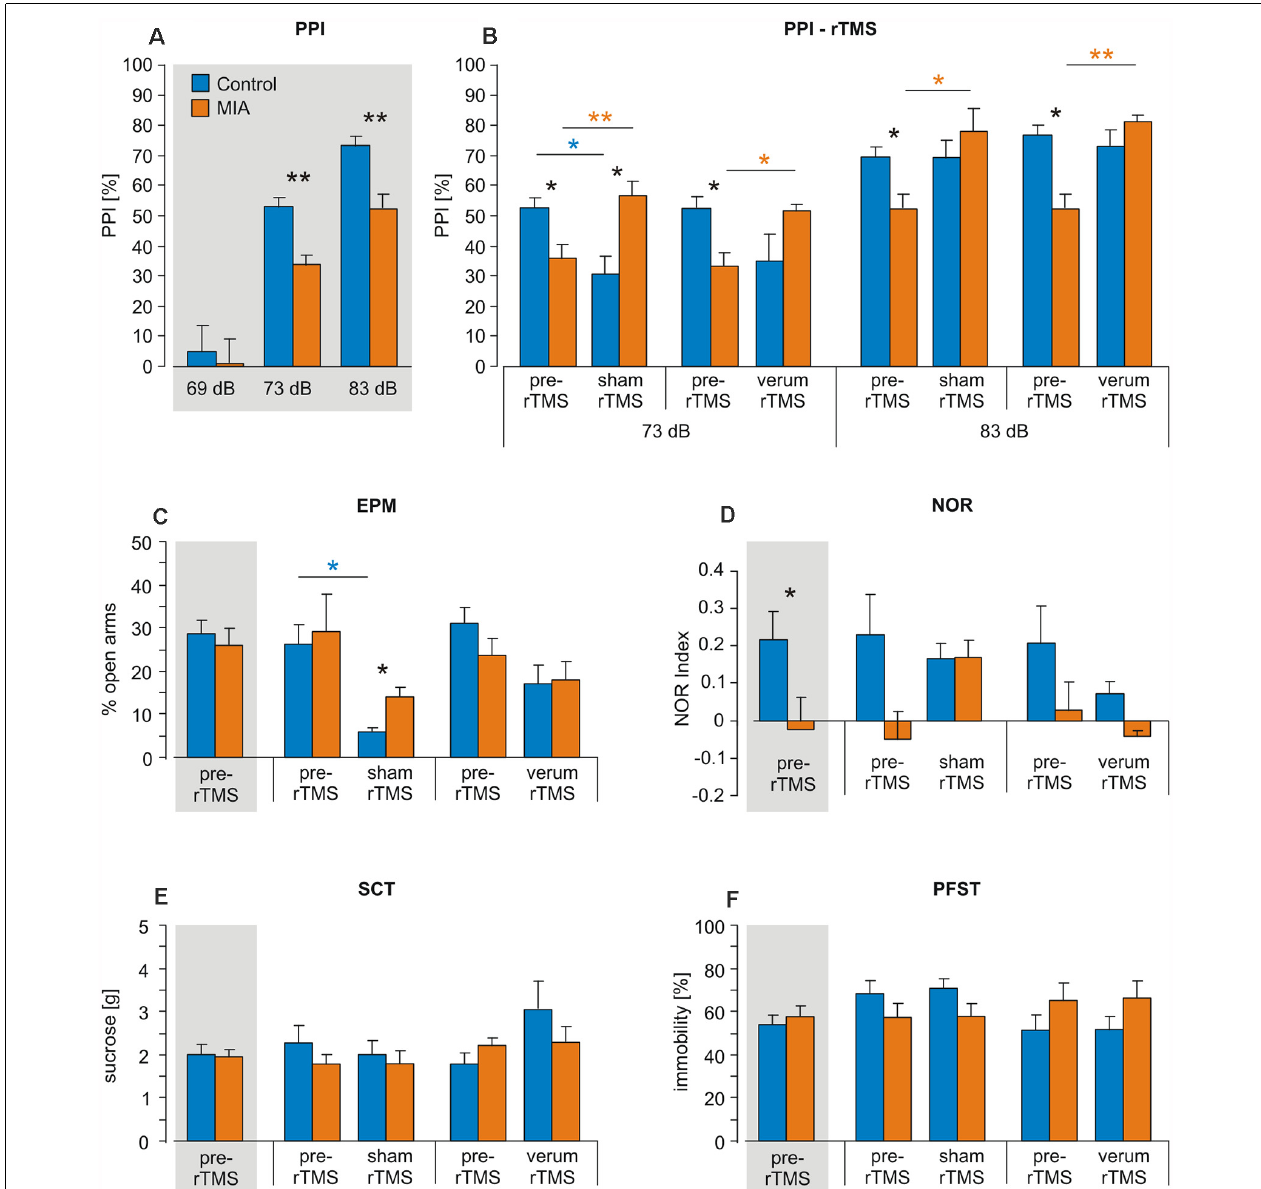
FIGURE 1 | Intermittent theta-burst stimulation (iTBS) applied to adult rats: effects on prepulse inhibition (PPI), elevated plus maze (EPM), novel object recognition (NOR), sucrose consumption test (SCT) and porsolt forced swim test (PFST). Maternal immune activation (MIA) and control rats ( n = 12 + 12) were tested for (A,B) PPI, (C) EPM, (D) NOR, (E) SCT and (F) PFST once before iTBS (pre-iTBS, gray shading: all pre-iTBS measures pooled) and a second time after either sham-iTBS or verum-iTBS ( n = 6 per group). Colored asterisks above lines indicate statistically significant differences between pre- and post-iTBS (sham or verum) data determined by paired t -test (controls: blue, MIA: orange, here pre-iTBS data shown separately for sham and verum groups) while black asterisks indicate significant differences between MIA and control rats as revealed by t -test for independent samples (two-sided). * p < 0.05, ** p < 0.01. Data are shown as group means ±